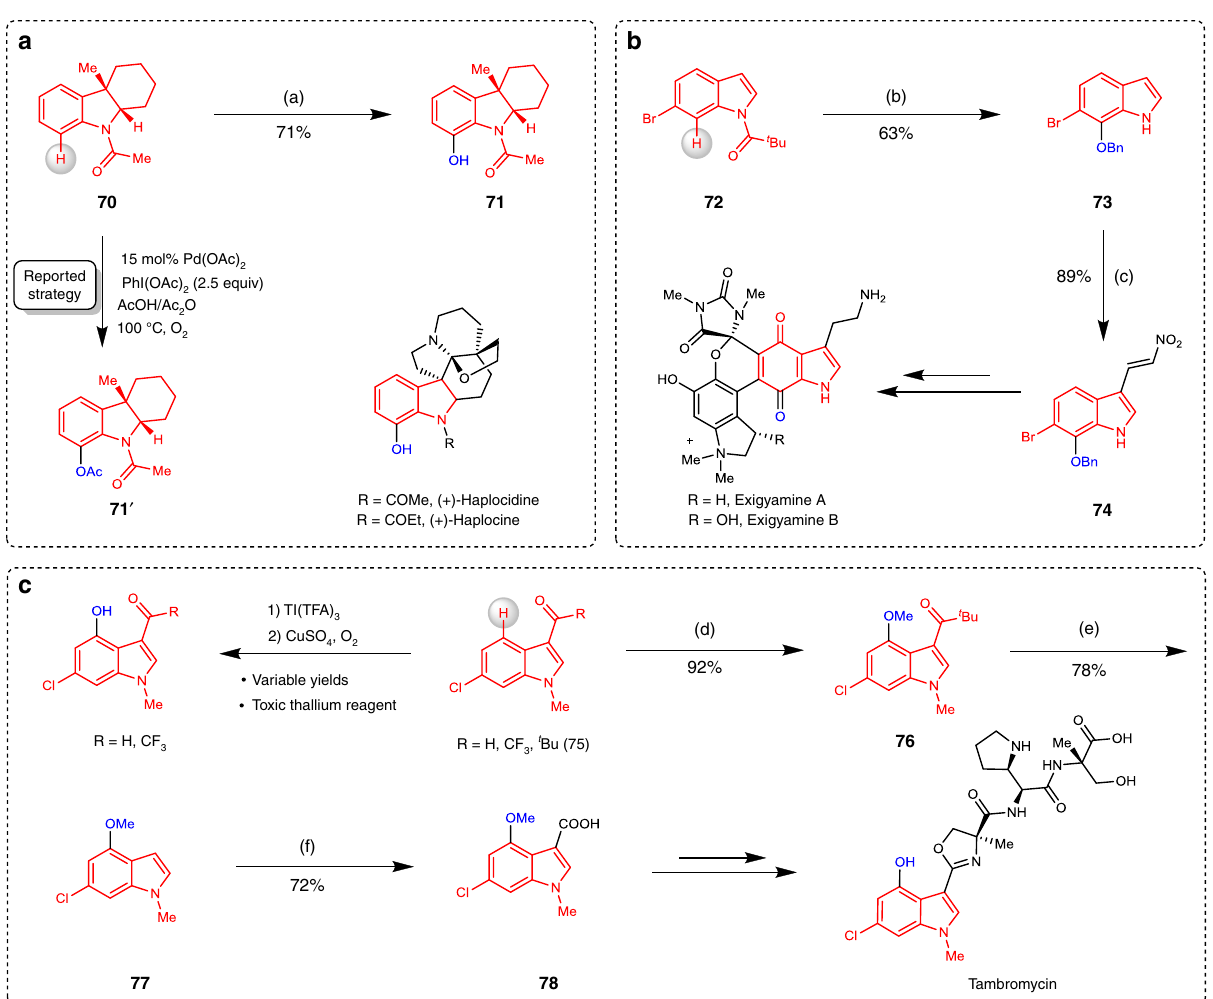
Fig. 4 Synthetic applications. a Using N -acylindoline 70 as a model substrate for the synthesis of ( + )-haplocidine and ( + )-haplocine. b Synthesis of the key intermediate 73 for the synthesis of the exiguamines. c Synthesis of the key intermediate 78 for the synthesis of tambromycin. Reagents and conditions: (a) 70 (0.2 mmol) and BBr 3 (0.6 mmol) in 0.5 mL DCM at 110 °C, 24 h; NaBO 3 ·4H 2 O (1.0 mmol) in 0.5 mL of THF and 0.5 mL of sat. K 2 CO 3 ,